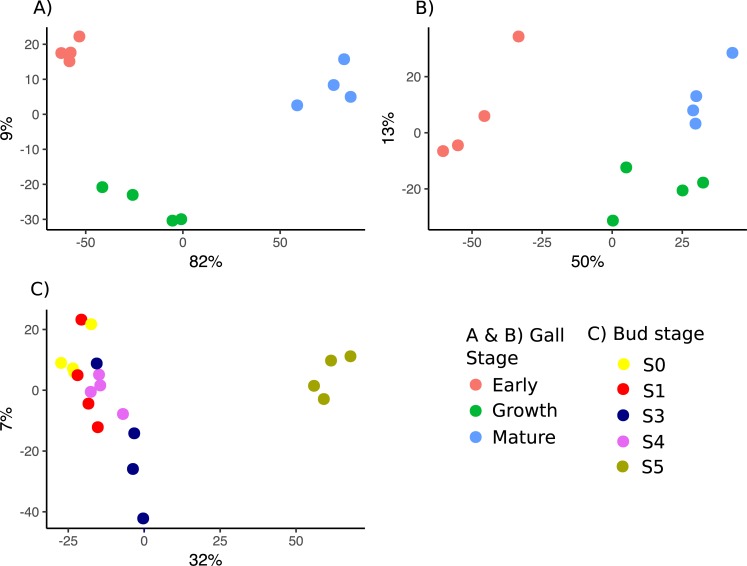
Overall similarity in patterns of gene expression within and among developmental stages of B. pallida galls and normally developing oak buds.Principle component analysis in DESeq2 of (A) gall wasp genes in gall tissues, (B) oak genes in gall tissues, and (C) oak genes in normal (ungalled) bud tissues. X-axes correspond to principle component one and y-axes to principle component two, and axis labels give the percentage of variance these axes explain in each analysis. The colour legend for each stage is given in the bottom-right quadrant. For both gall wasp and oak genes in gall samples, biologically independent replicates for the same developmental stage cluster together. Growth and Mature stage tissues are more similar for host oak tissues than they are for larval gall wasp expression. Stages S0-S4 of normally developing buds show incomplete differentiation by stage, while mature leaf tissues (S5) are clearly distinct from all earlier stages. Lack of clear separation between stages S0-S4 is maintained if S5 replicates are removed from the analysis (S2 Fig).